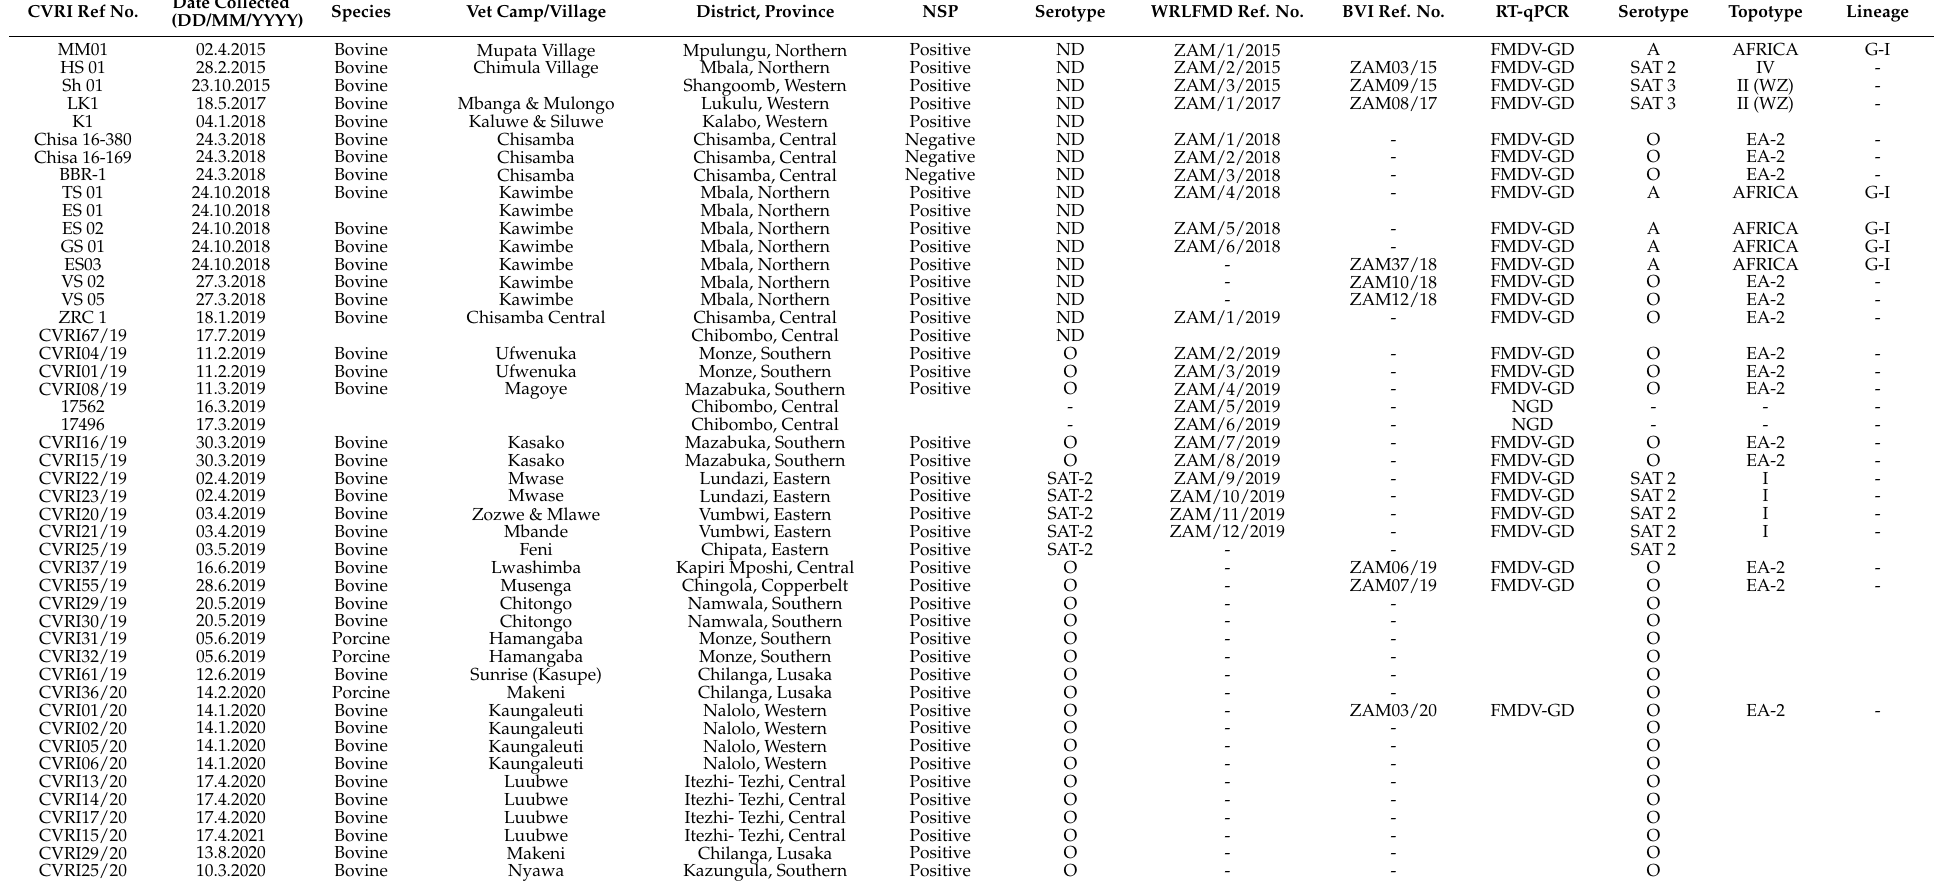
Table 1. Details of tissue samples described in this study